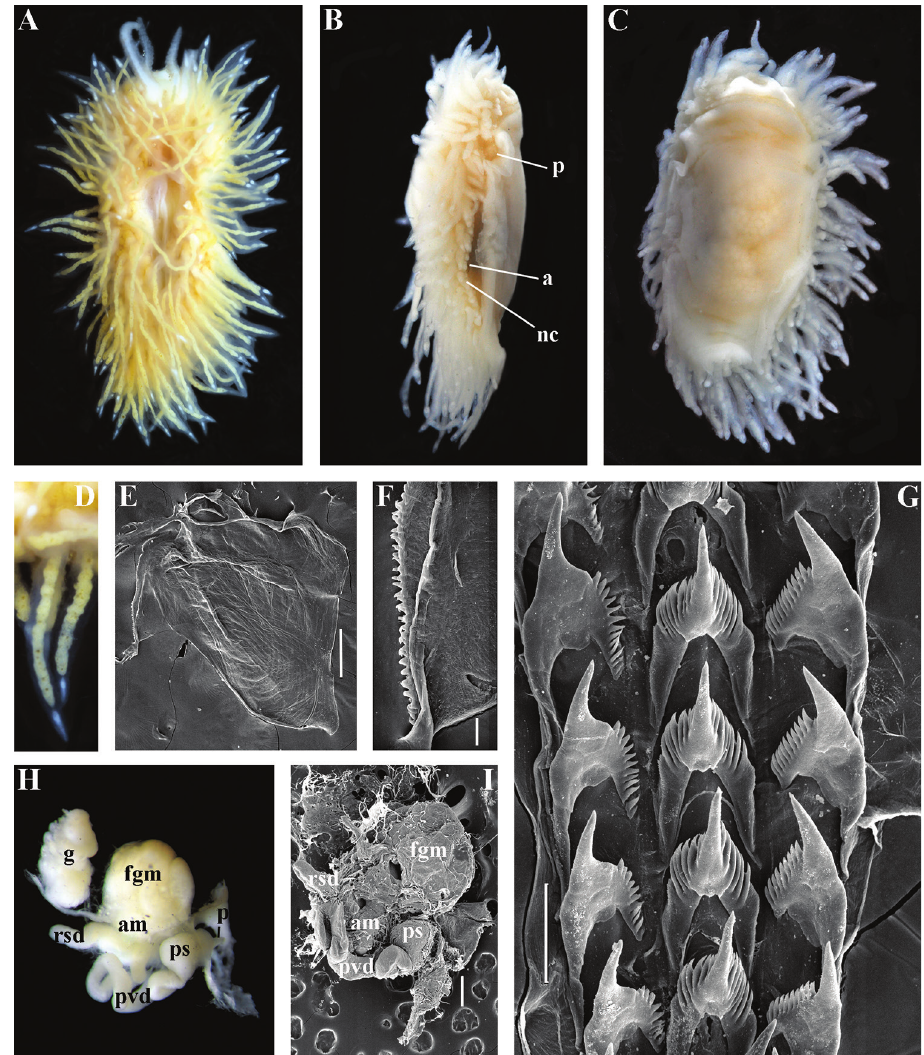
Figure 11. Polaria polaris (Volodchenko, 1946), comb. n. ZMMU Op-519. Laptev Sea, living specimen 12 mm in length: A dorsal view B latero-ventral view C ventral view D details of cerata E jaw, SEM F details of masticatory process of jaw, SEM G radular teeth, posterior part, SEM H reproductive system, light microscopy I reproductive system, SEM. Abbreviations: a anus am ampulla rsd distal receptaculum seminis fgm female gland mass; g gonad; nc continuous notal edge p penis ps penial sheath pvd pros- tatic vas deferens Scale bars: E, I = 300 μm; F = 30 μm; G = 100 μm. Photos of living specimens by O.L. Zimina, other photos and SEM images by A.V.